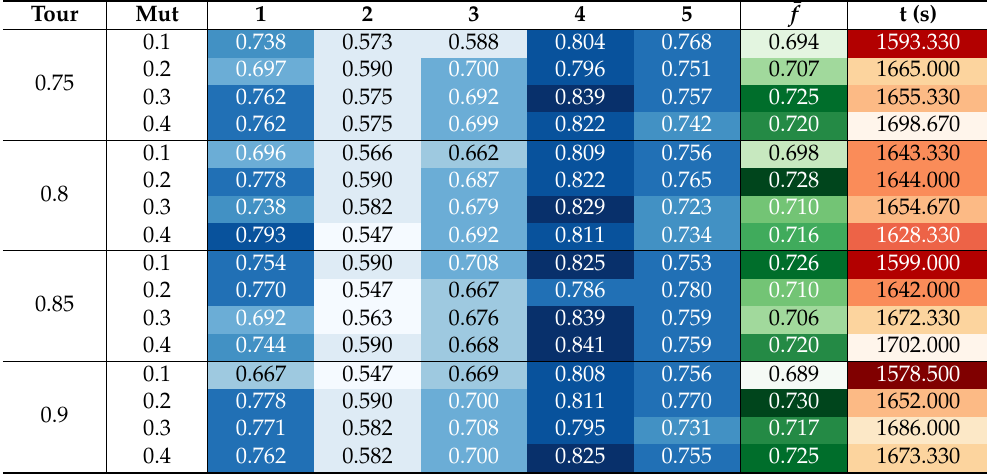
Table A5. Calibration results for map 534. Colored columns show fitness averages for each step (identified by step number), average over all steps ( ¯ f ), and runtimes (in seconds). Each row is a combination of two parameters: tournament probability (tour) and mutation rate